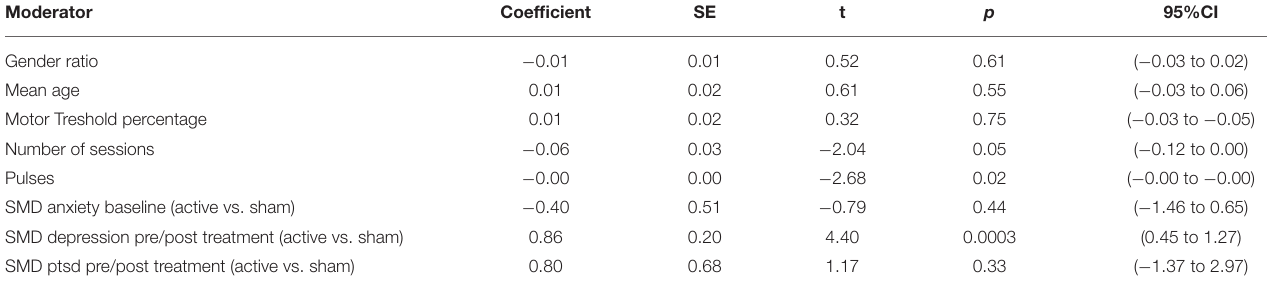
TABLE 5 | Meta-regression analysis.